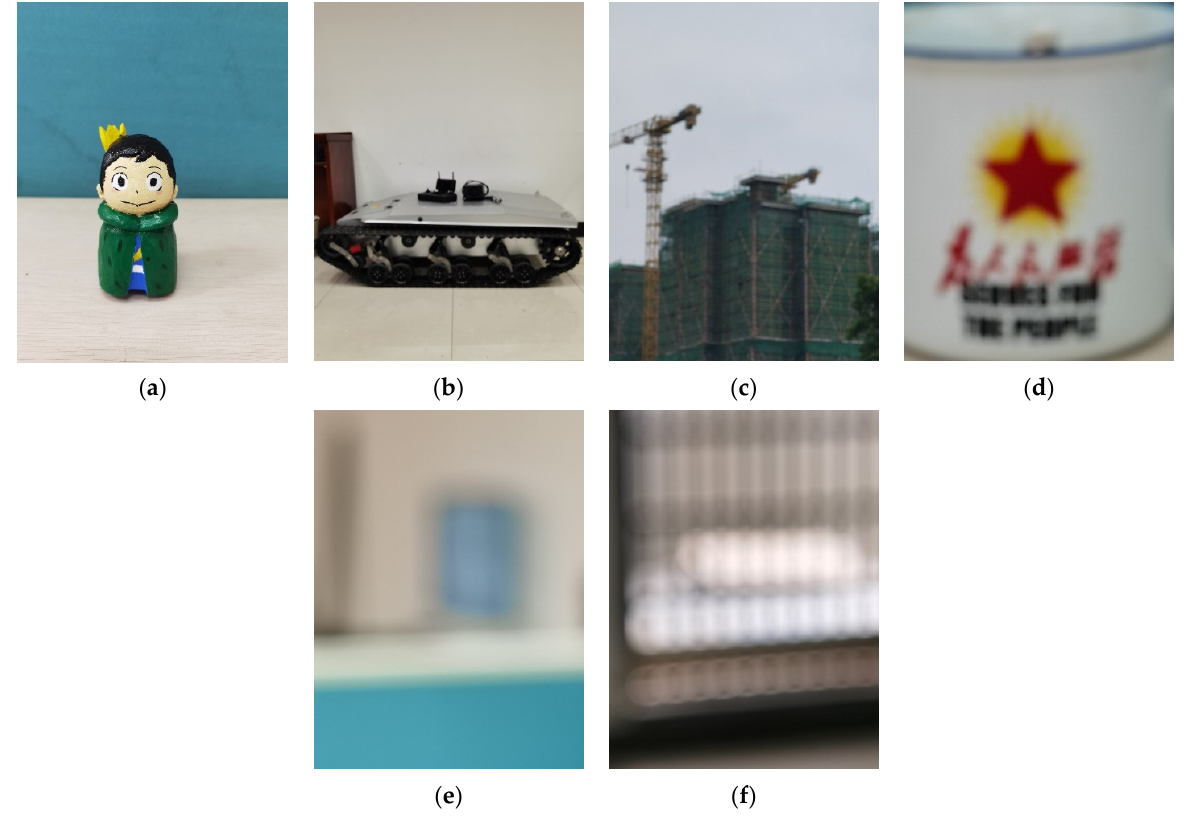
Figure 23. Real shooting images: ( a ) toy; ( b ) vehicle; ( c ) building; ( d ) cup; ( e ) indoor; ( f ) door.